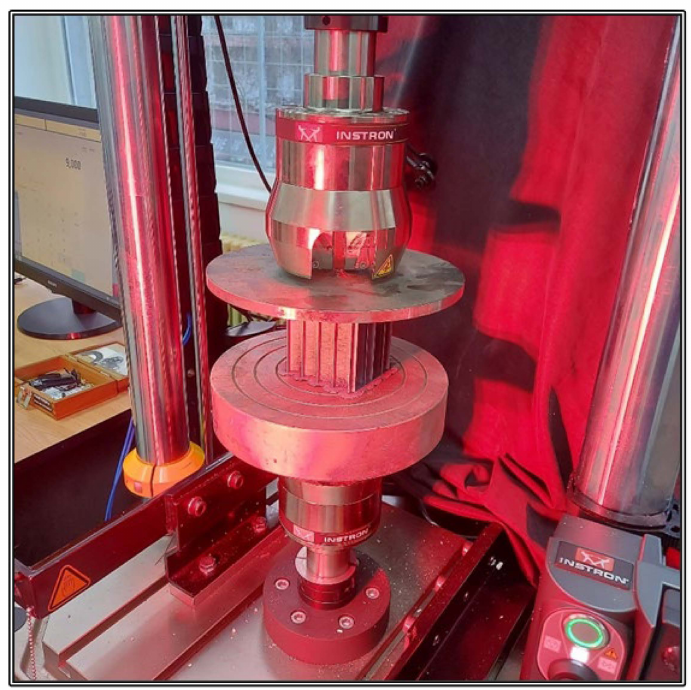
Figure 10. Compression test